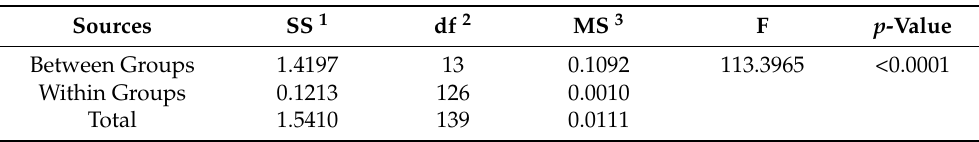
Table 7. ANOVA single factor applied to partial stem volume estimated with Huber’s formula when using a laser caliper by many users, α =